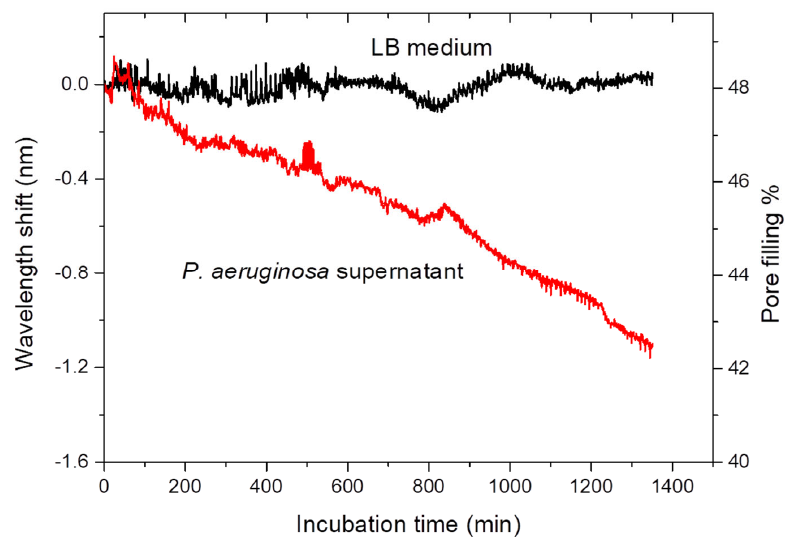
Figure 9. Plot of in situ RIfS measurement during incubation of a PLA-modified pSiRF sensor in sterile P. aeruginosa (PAO1) supernatants obtained from a 1.9 × 10 9 CFU mL − 1 suspension by filtration (black line) and in pure LB medium (red line). The PLA-modified pSiRF sensor was stable in LB for more than 22 h, whereas incubation in P. aeruginosa supernatant caused a quasi-linear blue shift in the wavelength. The spectral positions of the characteristic peaks were corrected by subtracting the wavelength obtained before incubation in the bacterial supernatant or in LB medium.